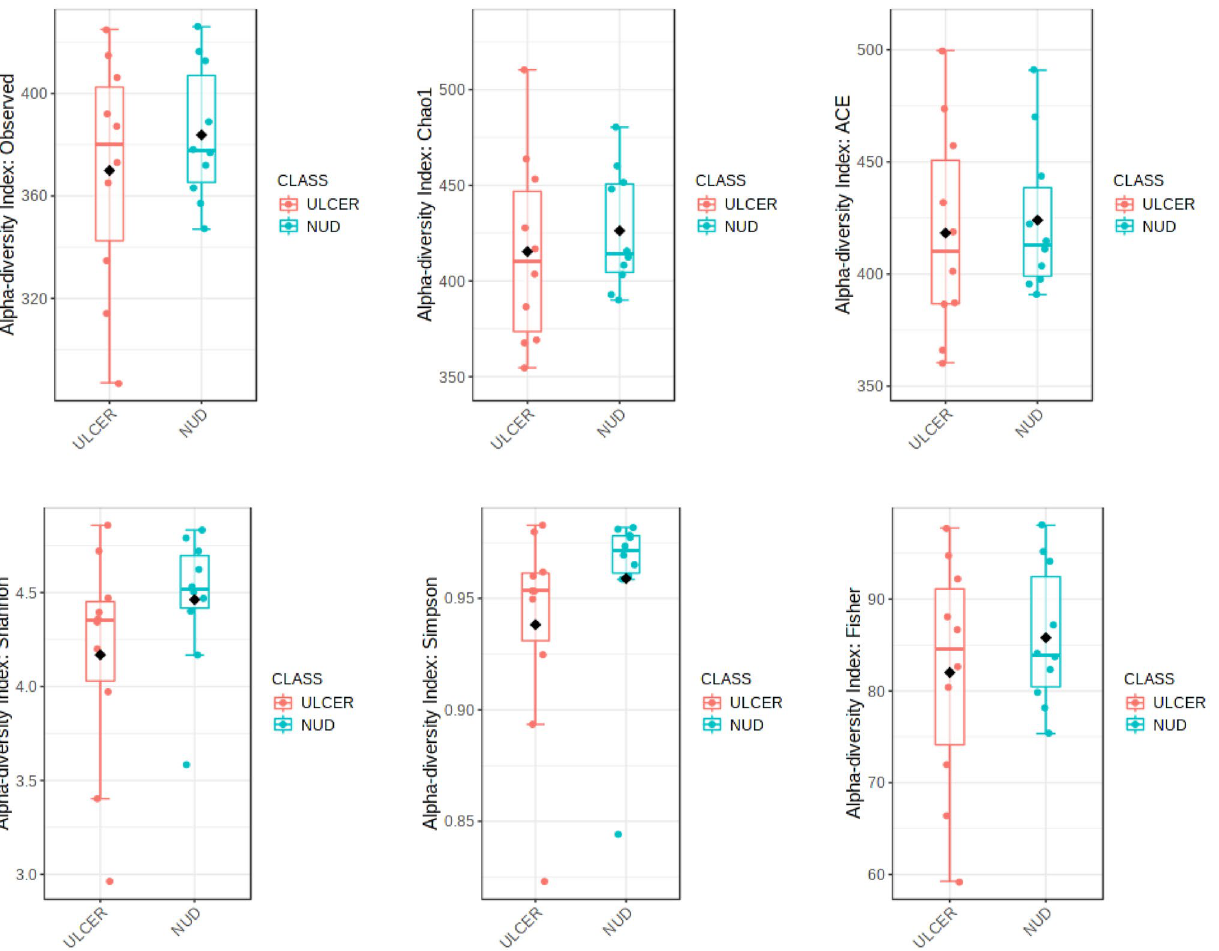
Figure 6. Comparison of alpha diversity indices in ulcer and non-ulcer microbiome at Species-level represented as a boxplot. Each boxplot represents diversity distribution within the study group, and are statistically not significant [Observed (p = 0.87), Chao1 (p = 0.42), ACE (p = 0.53), Shannon (p = 0.94), Simpson (p = 0.84), and Fischer (p =